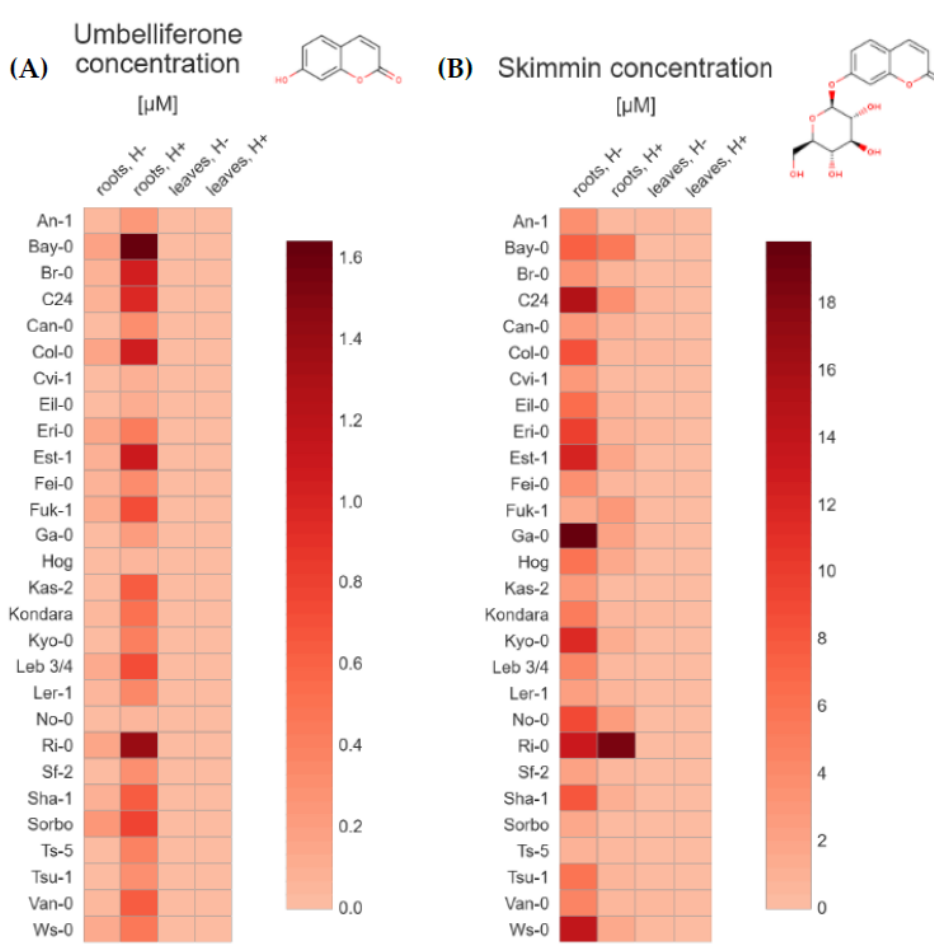
Figure 3. Heat maps based on the average ( A ) umbelliferone and ( B ) skimmin concentration (µM/ FW) in Arabidopsis tissue extracts from roots and leaves, without and after hydrolysis. The values used in the plots (https://app.displayr.com (accessed on 20 January 2021)) are the mean of 3 biological replicates. The mean values and standard deviations (±SD) are gathered in the supplementary materials (Table S2).